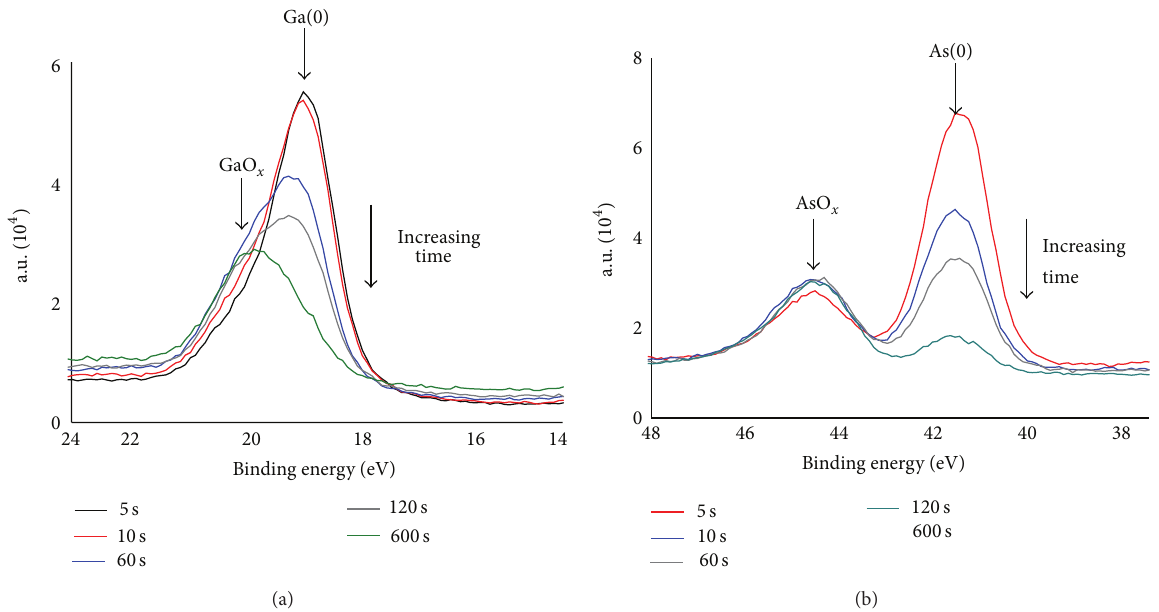
Figure 4: XPS spectra (a) in the Ga 3d region and (b) in the As 3d region for GaAs (100) samples immersed in 0.1 mM HAuCl 4 for increasing duration.